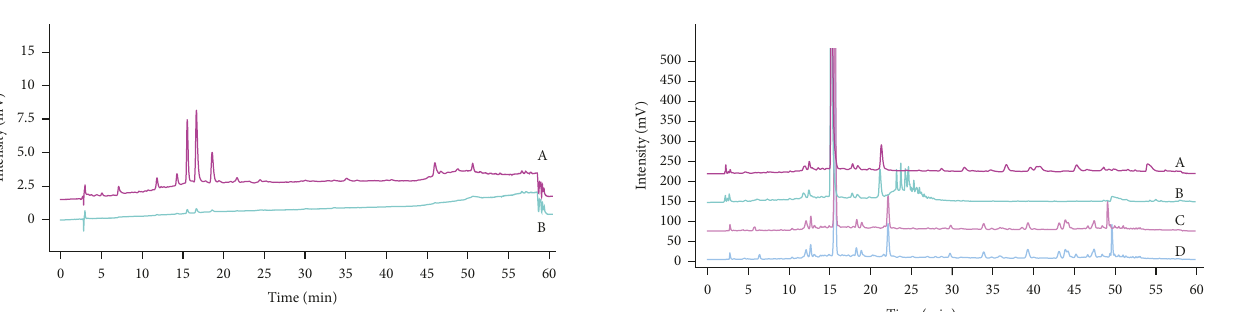
Figure 4: Effect of different chromatographic conditions on chromatogram (S38 sample: A for water-methanol, B for water- acetonitrile, C for 0.01% phosphoric acid water-methanol, D for 0.05% phosphoric acid water-methanol).